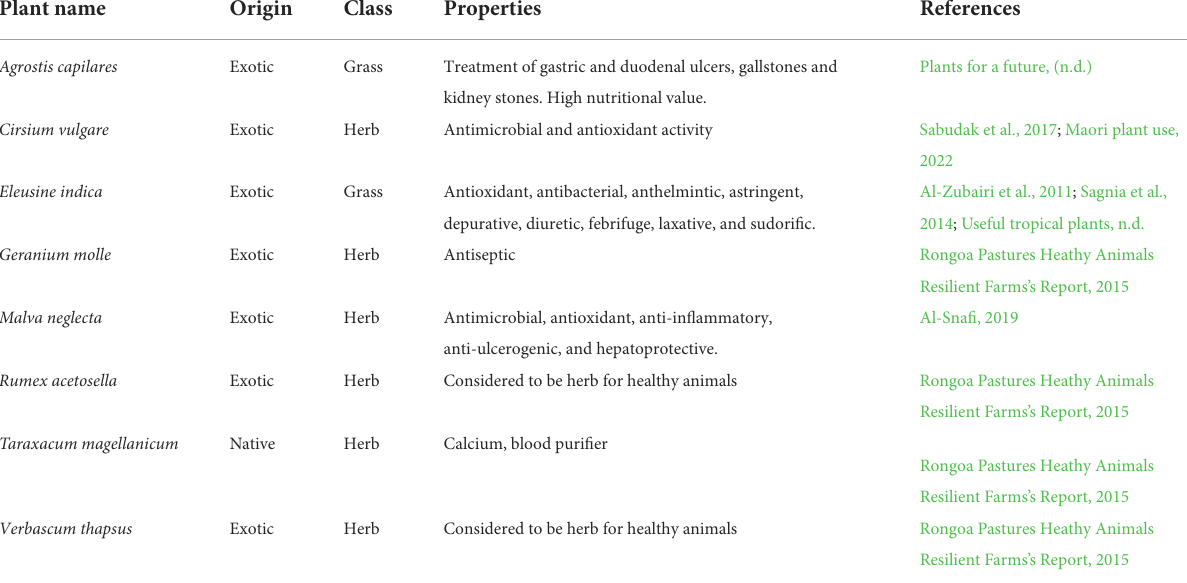
TABLE 2 Properties of plant species selected from the literature to illustrate a methodology to create healthscape maps, using the Lincoln University Mount Grand Station (LUMGS) high-country station as a case